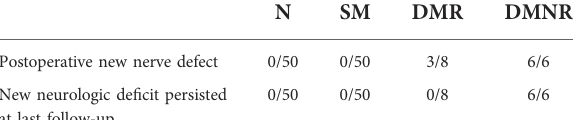
TABLE 2 New-onset neurologic de fi cit after surgery.